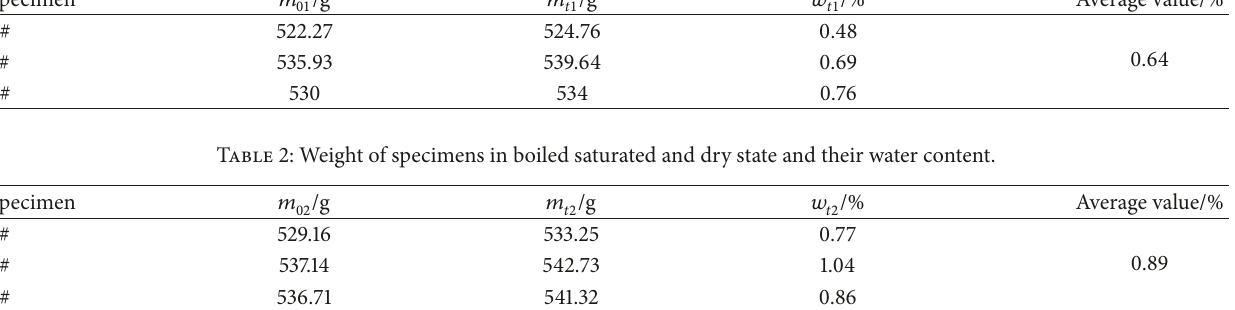
Figure 5: SEM and thin section image of igneous rock sample showing the microstructure (a), (b) and the components analysis of the dry igneous rock based on XRD pattern (c). Table 1: Weight of specimens in natural temperature, immersed saturated, and dry state and their water content. Specimen